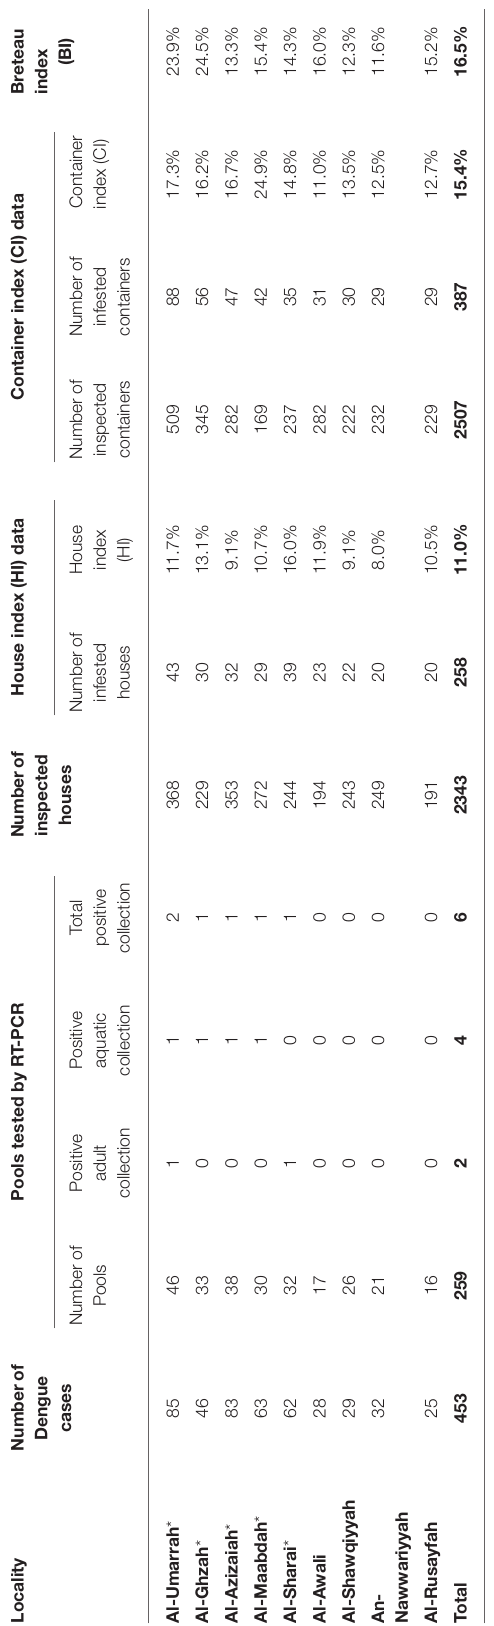
Five of the nine target localities (55.5%) yielded positive pools, while the other four yielded negative pools ( Table 2 and Supplementary 2